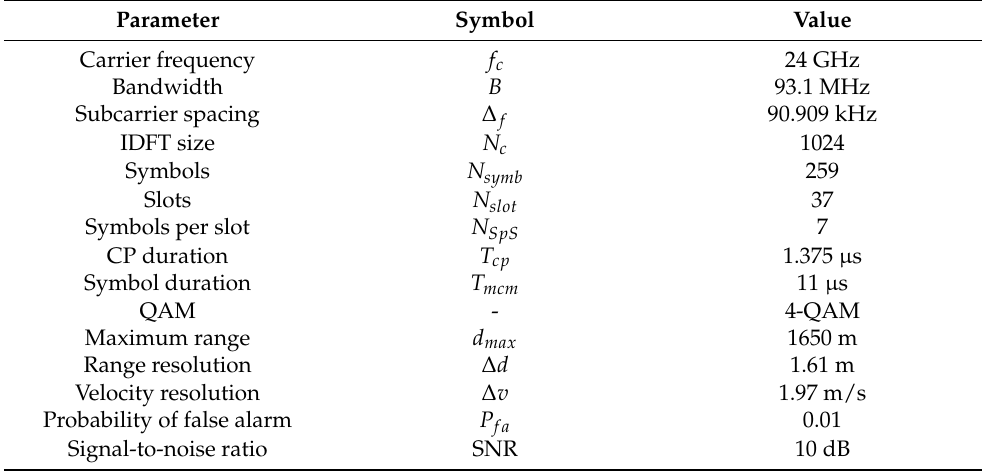
Table 1. Simulation parameters.